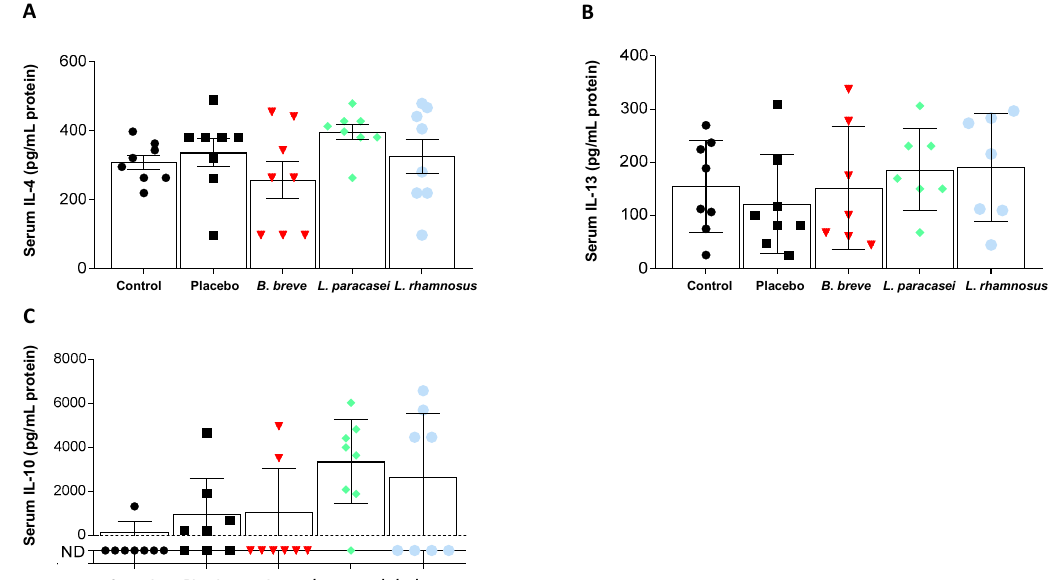
Figure 4. Serum concentration of anti-inflammatory cytokines. ( A ) IL-4, ( B ) IL-13, and ( C ) IL-10 of rats fed either placebo, B. breve CNCM I-4035, L. paracasei CNCM I-4034 or L. rhamnosus CNCM I-4036 for 30 days. Values are the means ± SEM. n = 8 per group. B, Bifidobacterium ; IL, interleukin; L, Lactobacillus .